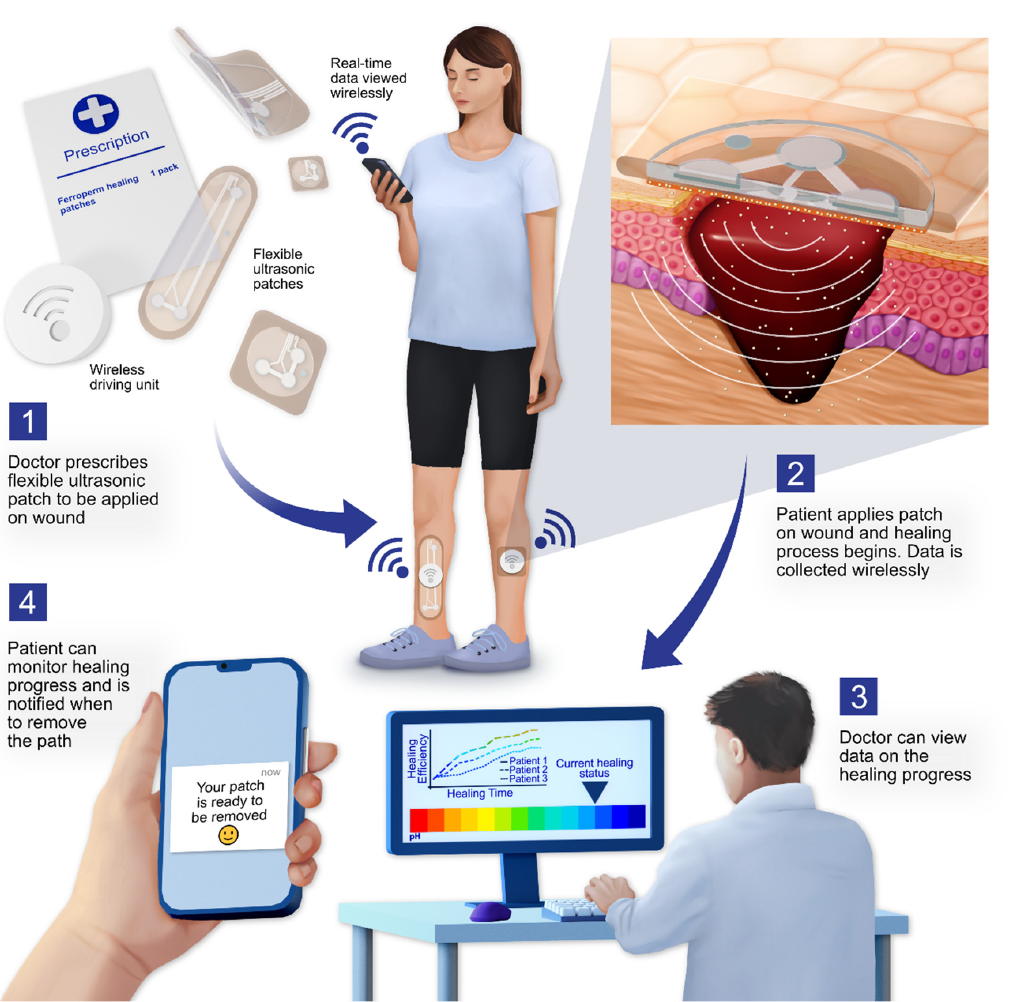
Figure 4. Treating wounds is a significant part of the healthcare financial plan with a high contribution from the cost of hospitalization and nurse time. Indeed, the focus should be on reducing these expense drivers by managing patients more effectively. A combination of passive dressings with flexible piezoelectric patches can address such shortcomings where patients can apply patches themselves at home. Clinicians and patients can monitor the treatment thanks to integrated tracking